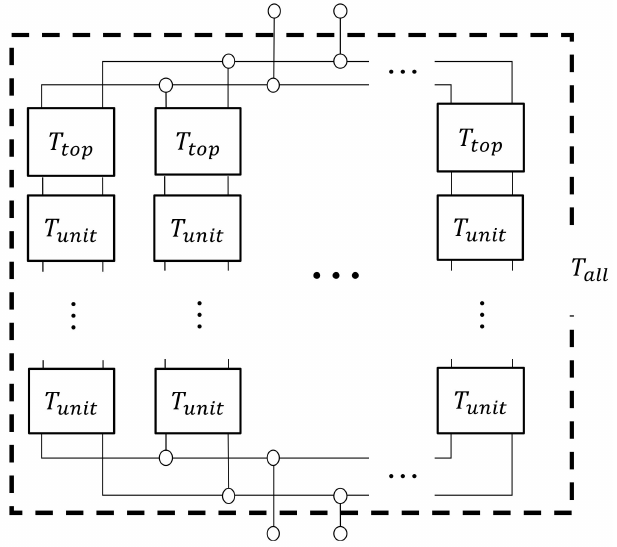
Figure 12. Equivalent circuit of the whole sample (parallel connection of the cascaded T unit